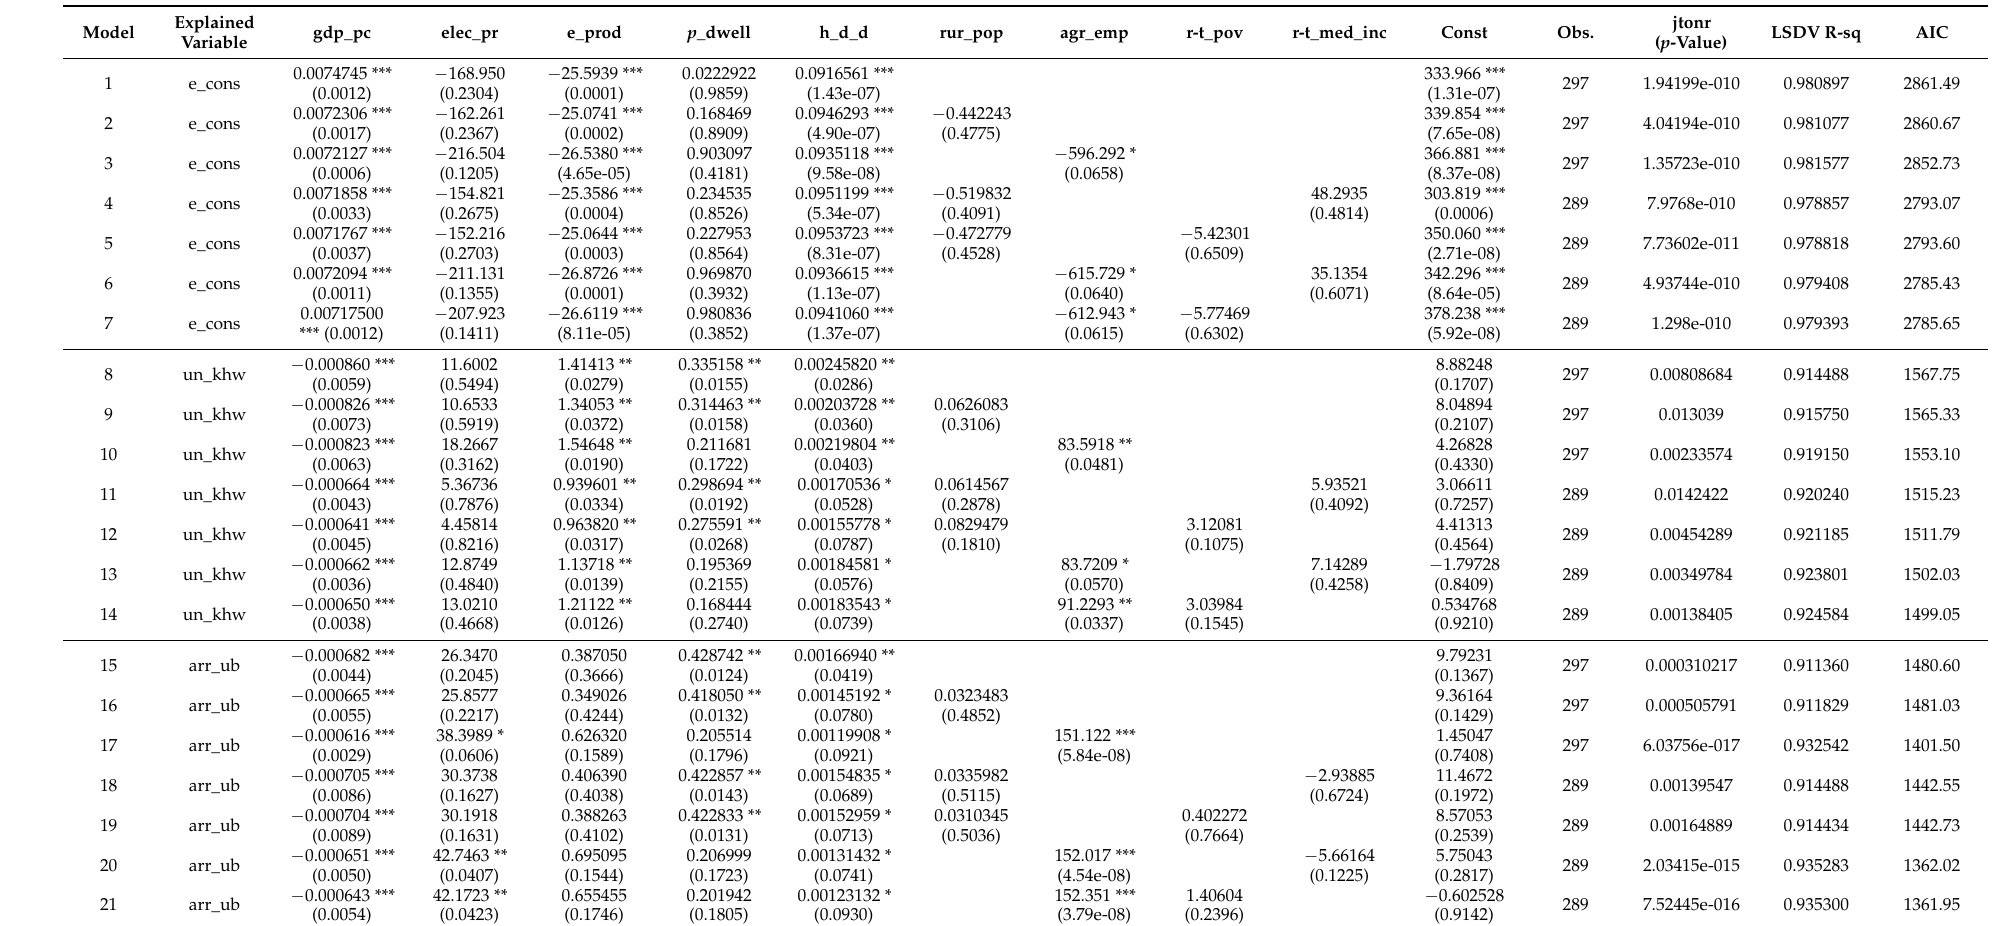
Table 3. Models of energy poverty estimations a